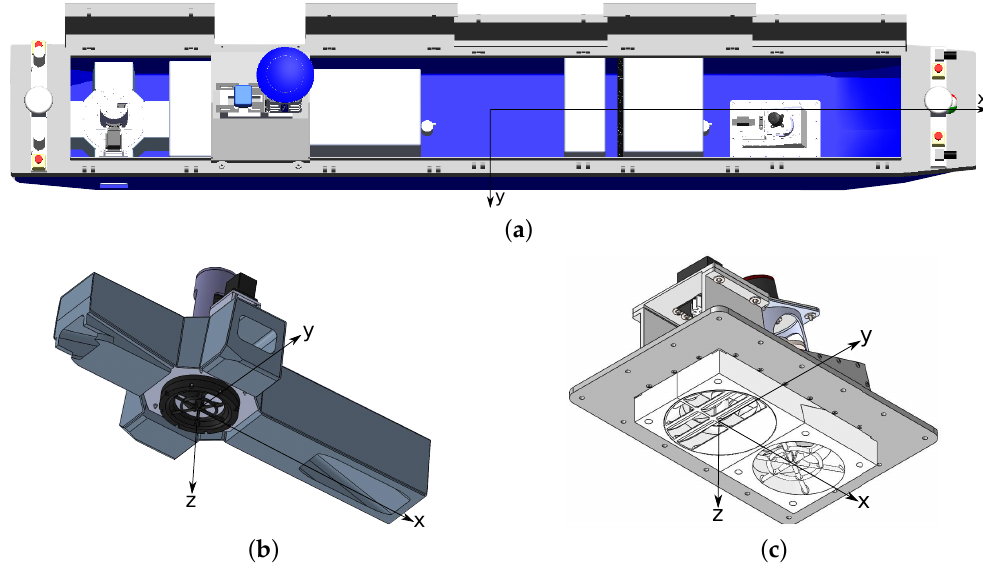
Figure 2. ( a ) slightly tilted top view of the design drawing of the complete vessel, ( b ) tilted bottom view of the four-channel thruster, adapted from [7,8], and ( c ) tilted bottom view of the steering-grid thruster, adapted from